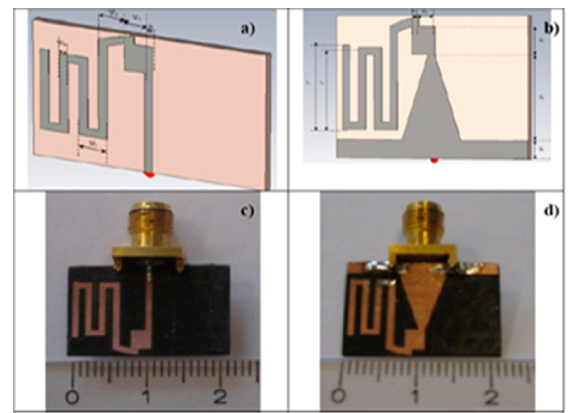
Figure 8. ( a ) The design of the antenna at the front and ( b ) at the back; ( c ) fabricated antenna at the front; ( d ) at the back and [30]. Sensors 2017 , 17 , 565